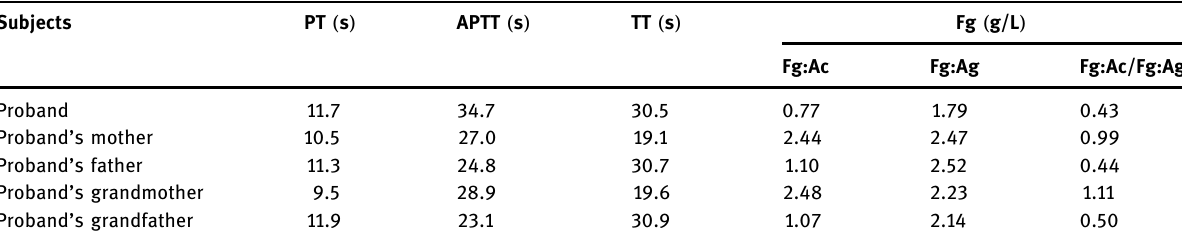
PT, prothrombin time; APTT, activated partial thromboplastin time; TT, thrombin time; Fg, fi brinogen; Fg:Ac, fi brinogen activity; Fg:Ac, fi brinogen